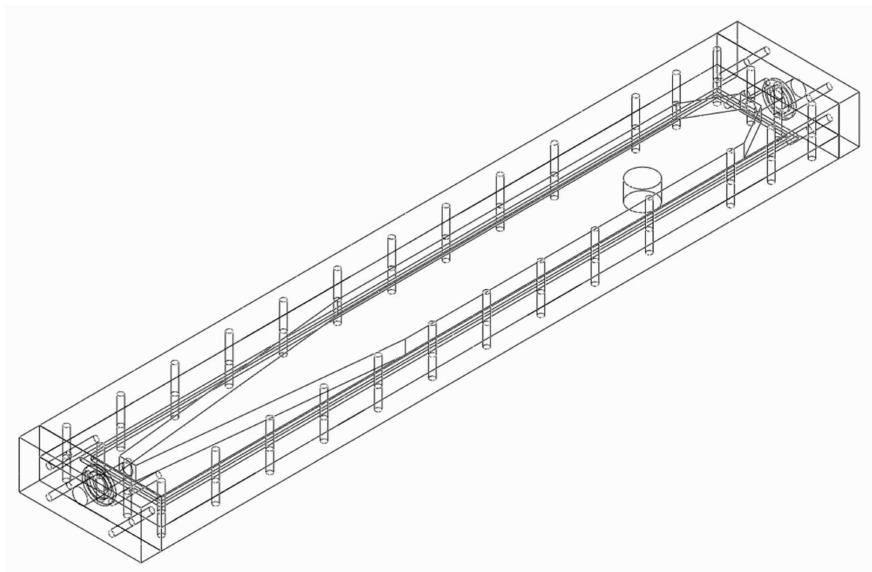
Figure A1. CAD drawing of the used flow